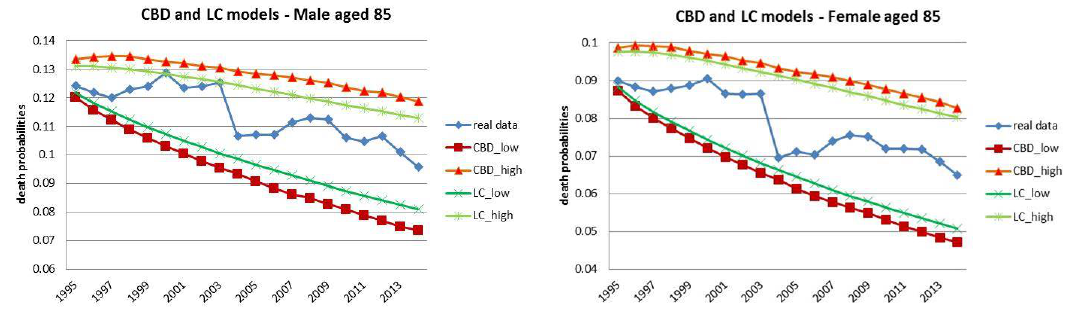
Figure 10. Fixed Horizon Backtest forecast: comparison between CBD and LC confidence intervals at age